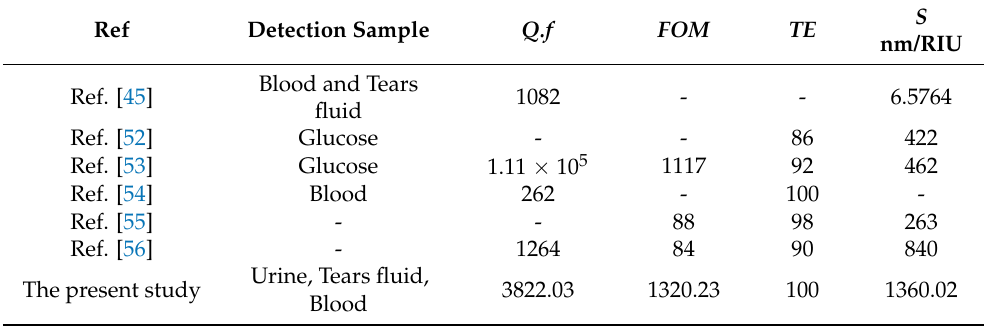
Table 4. Comparison of sample important characteristics of the proposed structure such as quality coefficient, transmission power, sensor sensitivity and figure of merit with the previously struc- tures.